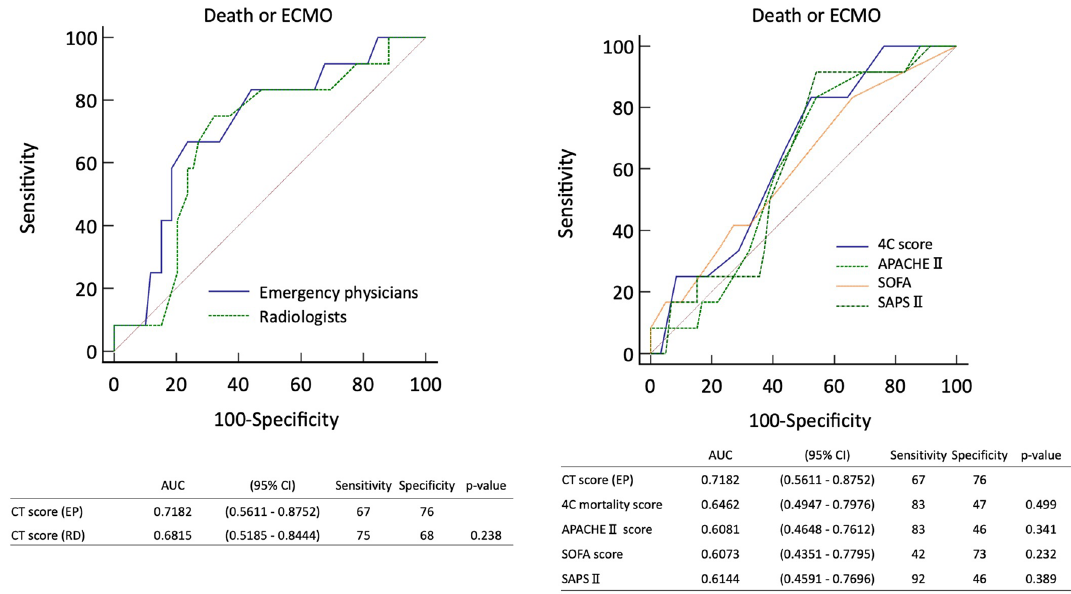
Figure 2. Performance of CT score and prognostic score for predicting death or ECMO management. The figure on the left shows the ROC curve for the emergency physicians versus radiologists’ results. The figure on the right shows the ROC curve for the 4C mortality score, APACHE II score, SOFA score, and SAPS II versus the CT score of emergency physicians. AUC, area under the curve; CI, confidence interval; EP, emergency physician; RD, radiologist; 4C, Coronavirus Clinical Characterisation Consortium; APACHE, Acute Physiology and Chronic Health Evaluation; SOFA, Sequential Ogan Failure Assessment; SAPS, Simplified Acute Physiology